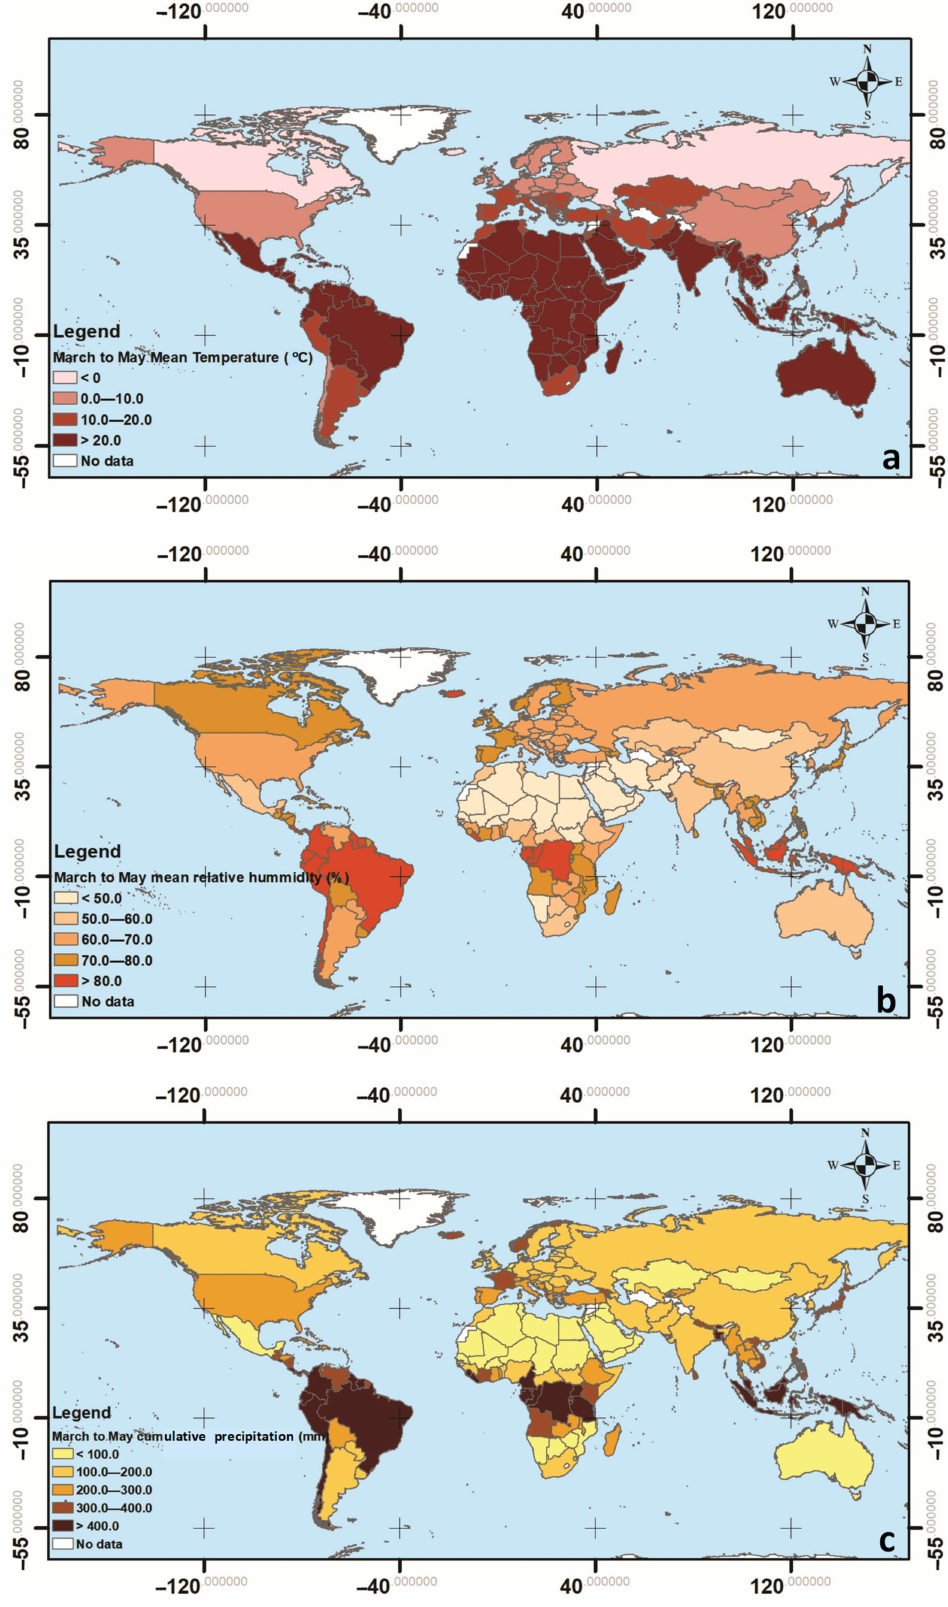
Figure 3. Worldwide distribution of ( a ) mean temperature, ( b ) mean relative humidity, and ( c ) cumulative precipitation for the period of 1 / 3 / 2020–31 / 5 /